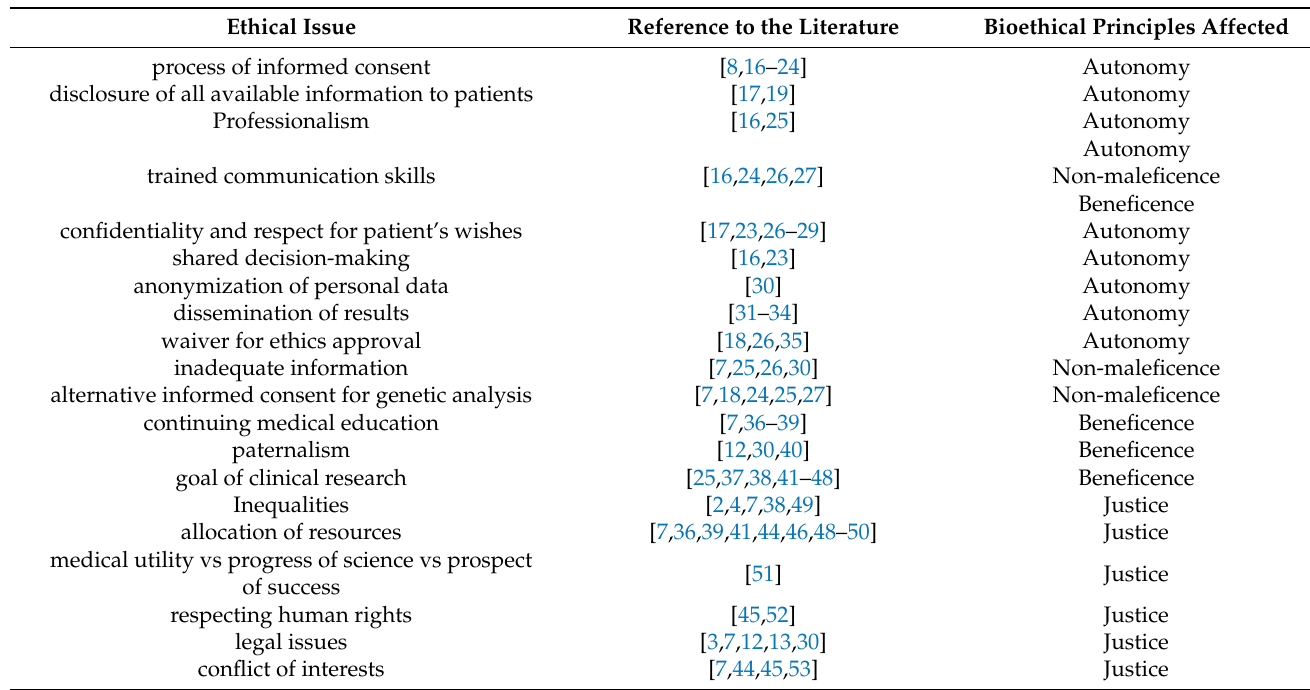
Table 1. Ethical issues identified in the